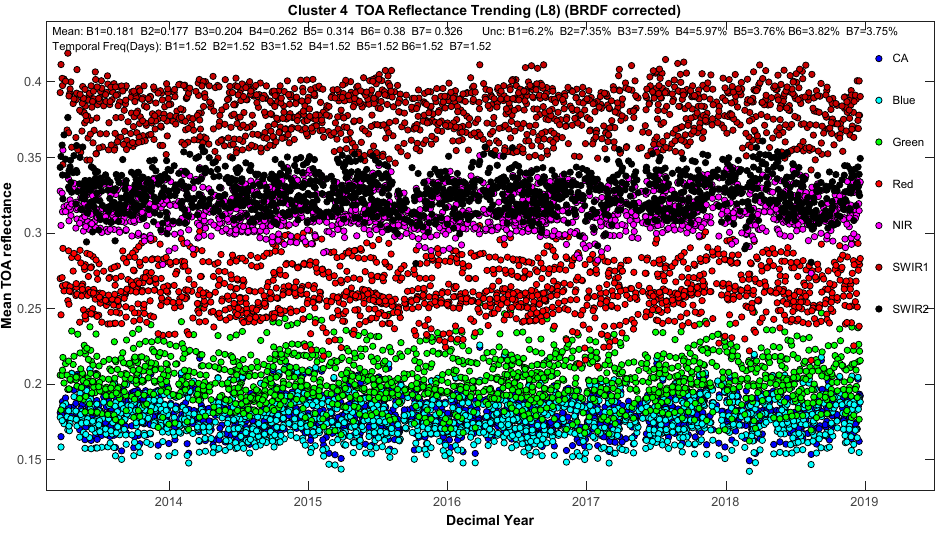
Figure 13. Temporal trending of OLI over Cluster 4. Table 7. Mean TOA Reflectance with Standard Deviation and Uncertainty of Cluster 4 optimized path/rows by band, derived from 30 m image data.